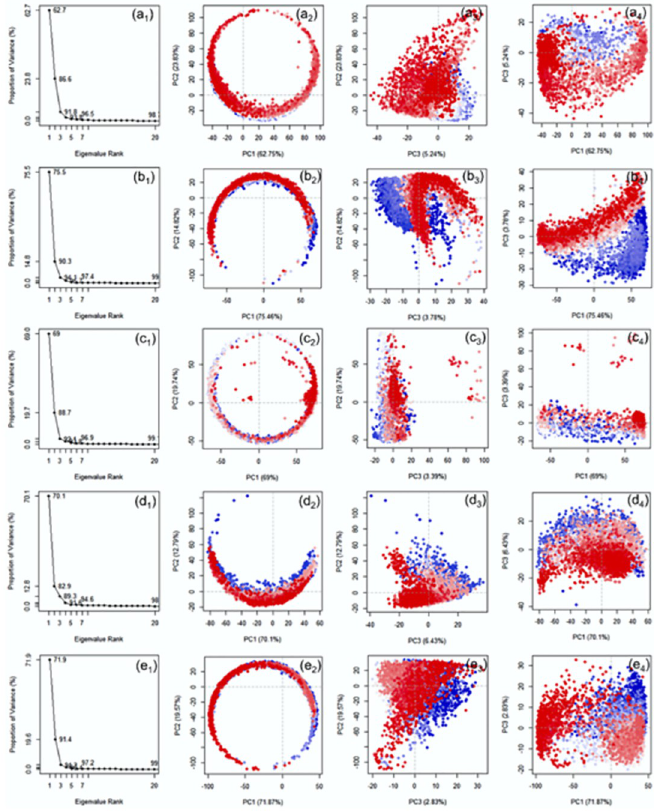
Fig 13. Principal component analysis for the simulation trajectories generated at 300K with varied pH values, viz. pH5 (a 1 -a 4 ), pH6 (b 1 -b 4 ), pH7 (c 1 -c 4 ), pH8 (d 1 -d 4 ), pH9 (e 1 -e 4 ). In the X-axis (Eigenvalue Rank) represents the principal components (PCs) while Y-axis represents the percentage of total variance explained by each individual principal component. The scatter plots represent the distribution of extracted essential motion between two PCs while colour change from red to blue through white marks for the periodic fluctuations experienced by the residue during 100 ns MD